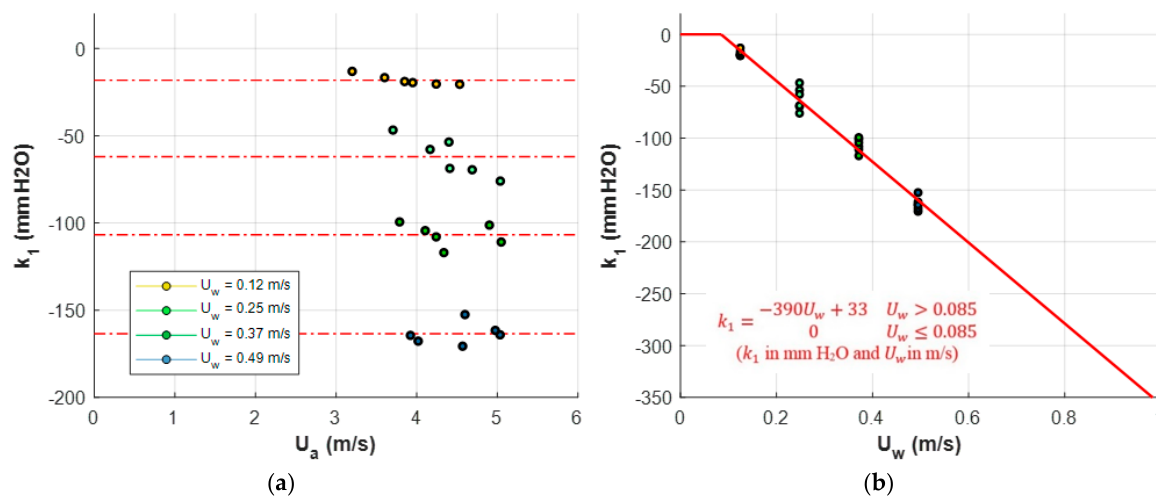
Buildings 2021 , 11 , x FOR PEER REVIEW Figure 6. Empirical coefficient k (cid:2869) plotted as a function of ( a ) normalized air velocity U (cid:2911) ( b ) normalized water velocity Figure 6. Empirical coefficient k 1 plotted as a function of ( a ) normalized air velocity U a ( b ) normalized water velocity U w . U (cid:2933) .